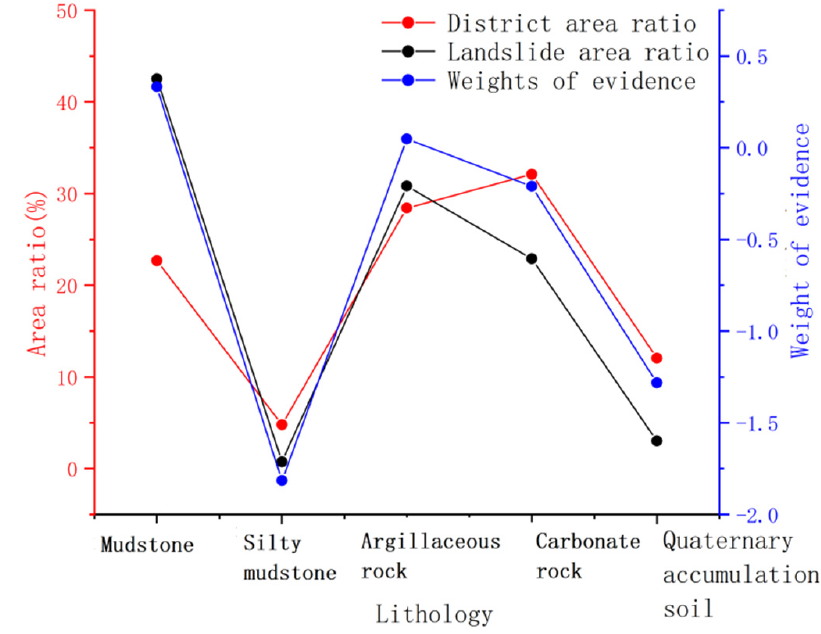
Figure 8. Lithology statistical analysis results.